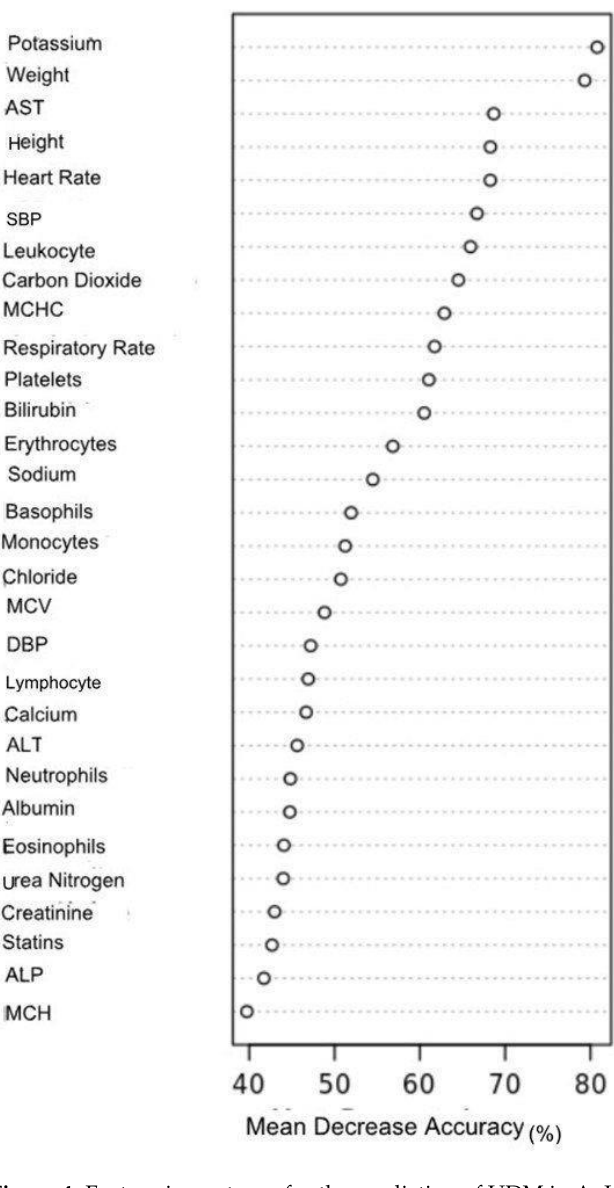
Figure 4. Feature importance for the prediction of UDM in AoU Research Program 2023. The X-axis represents the mean decrease in model accuracy, which is expressed as a percentage (%).